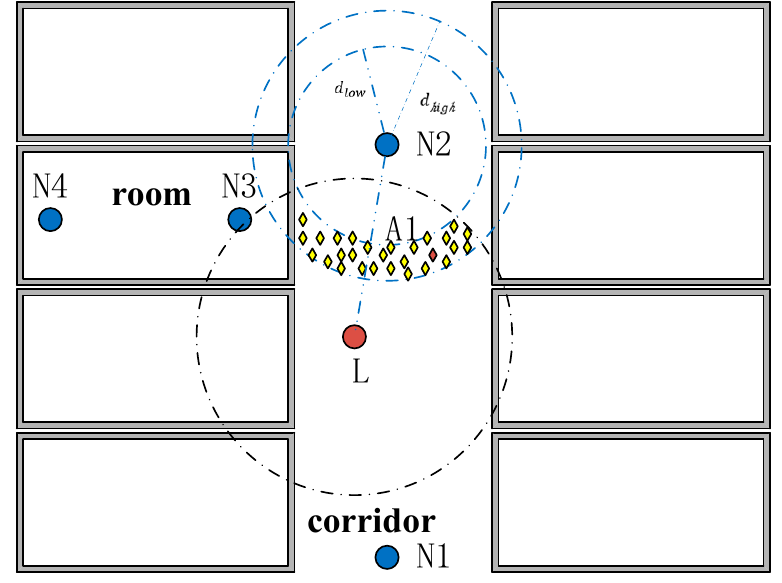
Figure 6. The schematic drawing of particle selection.